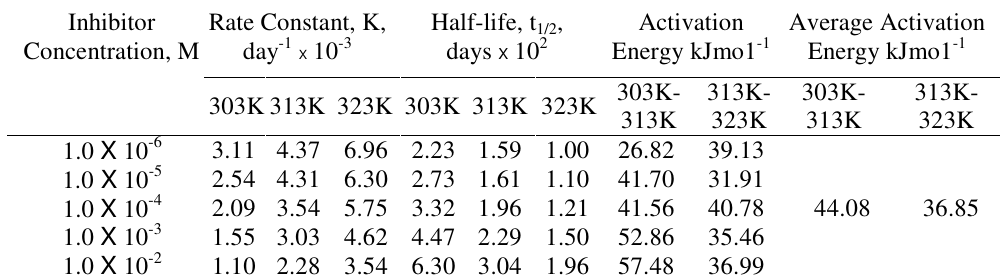
Table 2. Kinetic data for mild steel in 2 M HCl containing 2-benzoylpyridine from weight loss measurement.